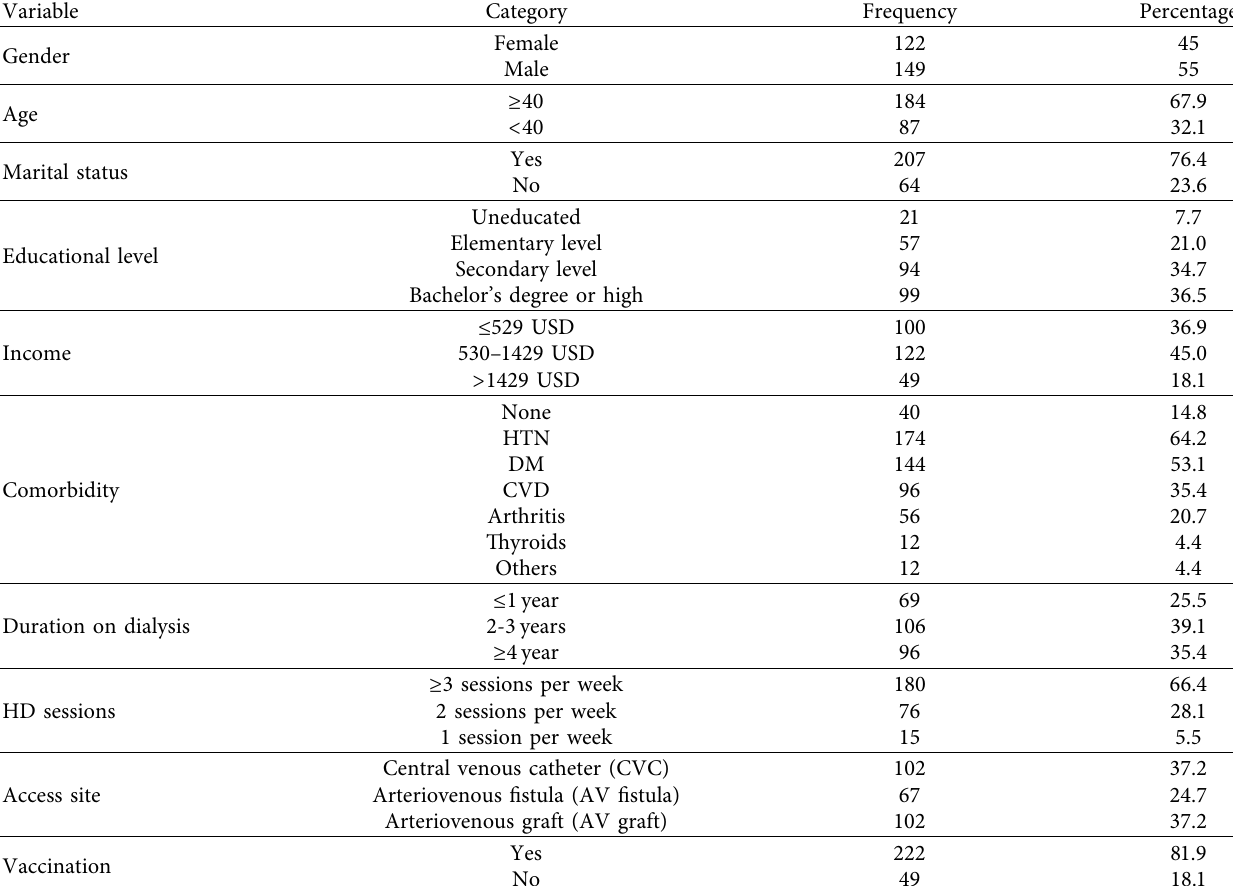
Table 1: Baseline characteristics of the study population ( n �